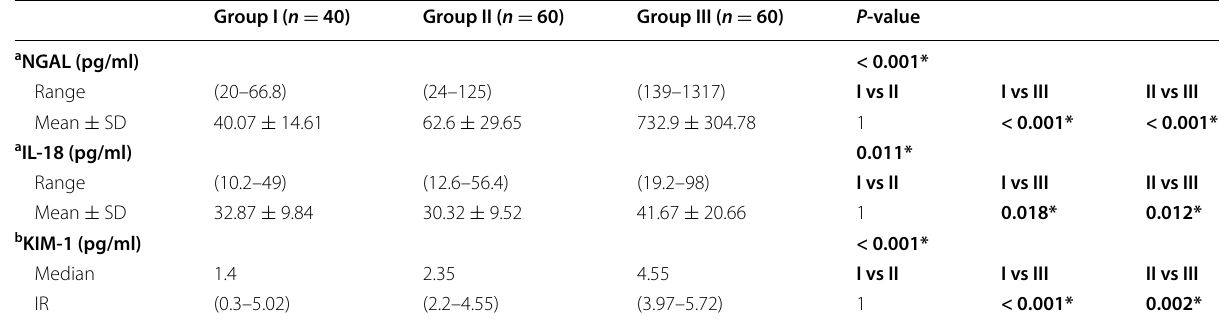
Bold values indicate significant results *Significant difference at p ‑value < 0.05 a